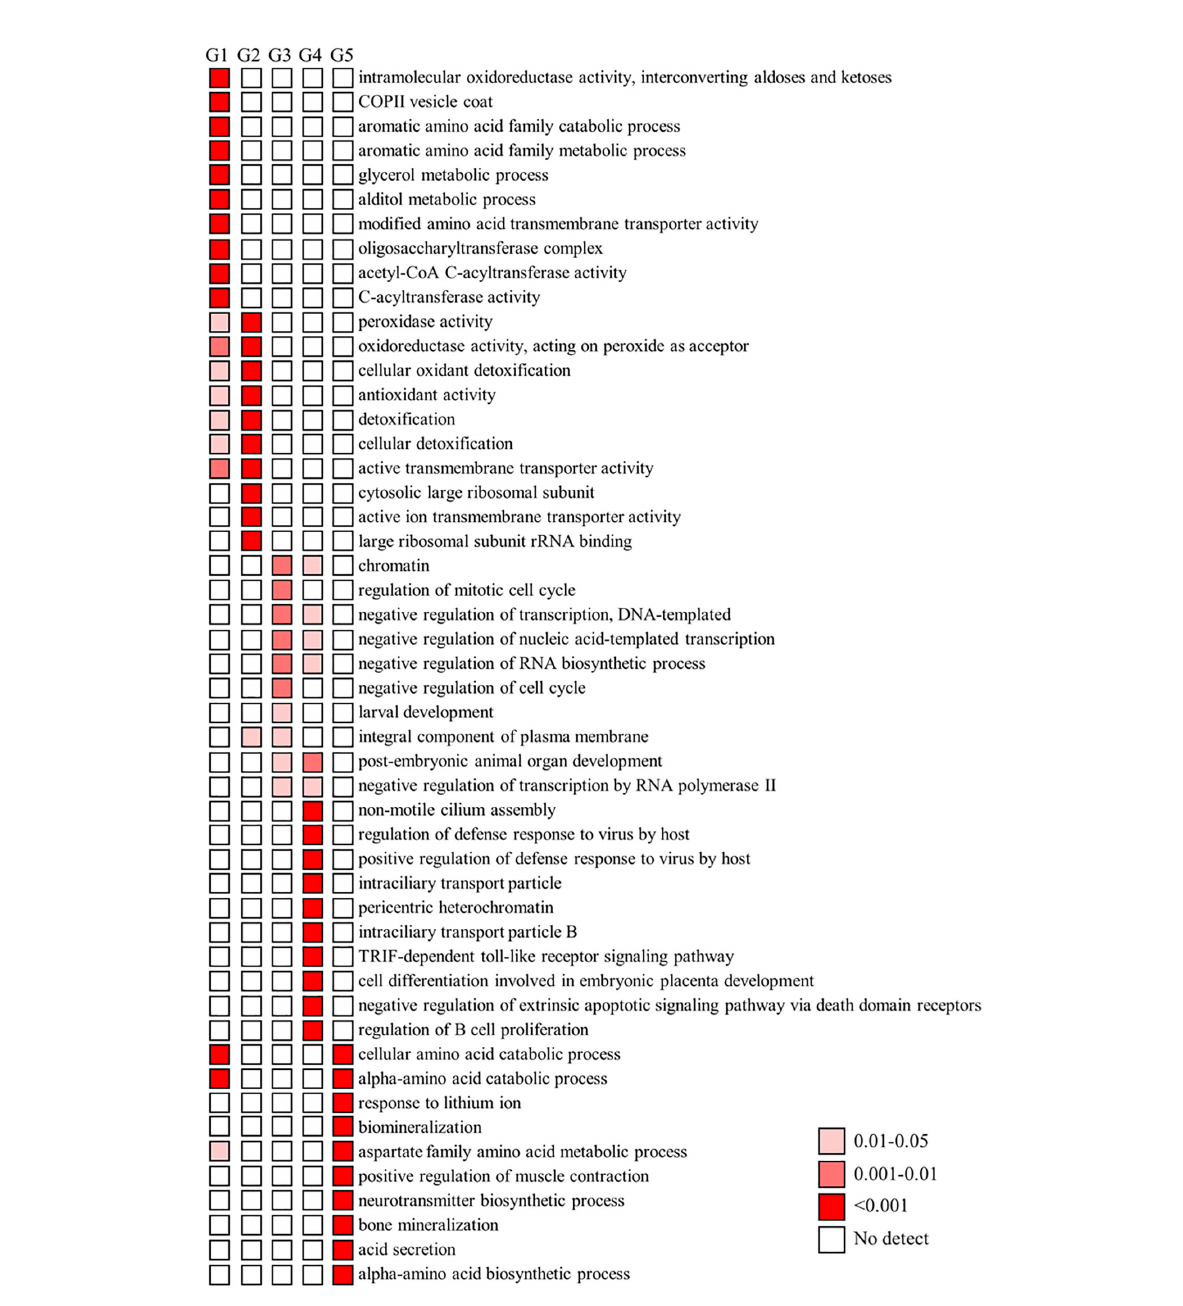
FIGURE 5 GO enrichment analysis of DEGs. The dominant GO (Gene Ontology) categories of differentially expressed genes (DEGs) in fi ve groups. Temporal expression pro fi les of these fi ve groups shows in Figure 4 G,